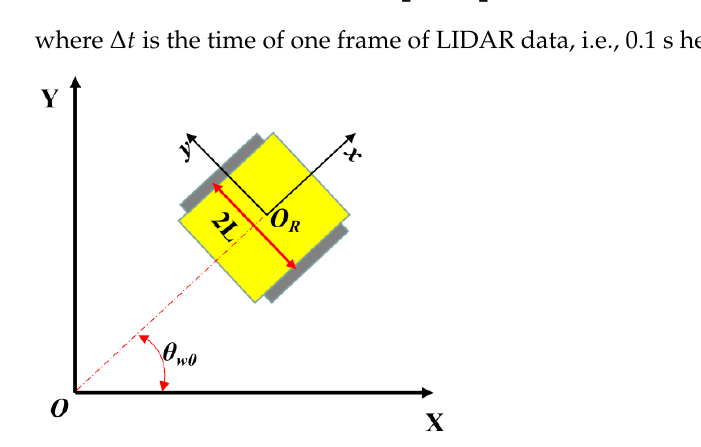
Figure 5. Schematic diagram of the PVSR motion model.